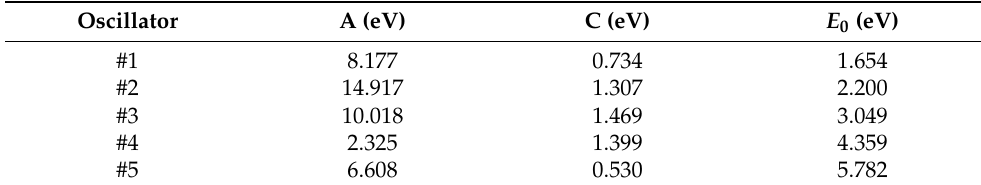
= 1.766 and = 0.349 eV 𝜀𝜀 ∞ 𝐸𝐸 𝑔𝑔